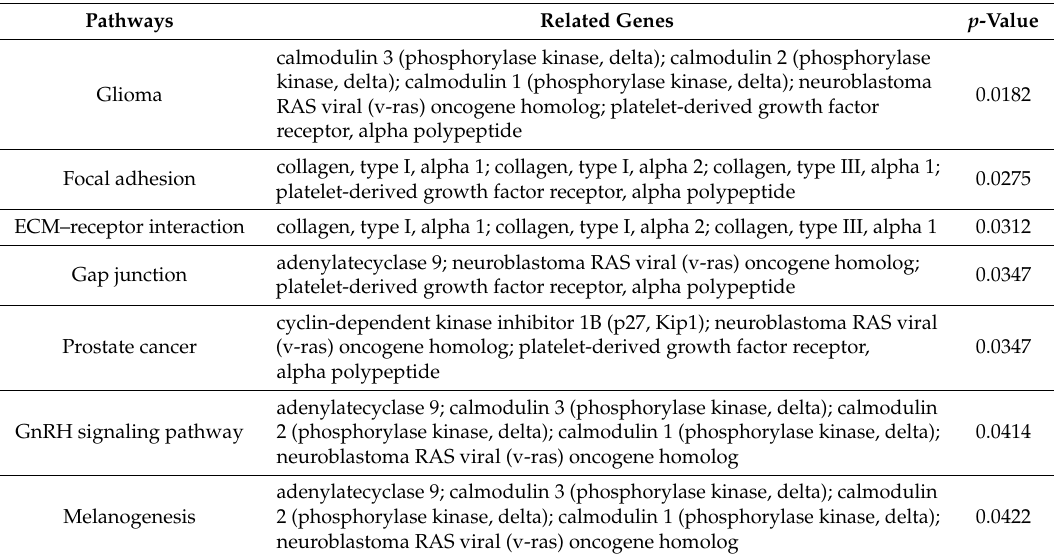
Table 3. The KEGG pathways that are enriched with predicted targets of miR-196a by DAVID. Table 3. Cont.